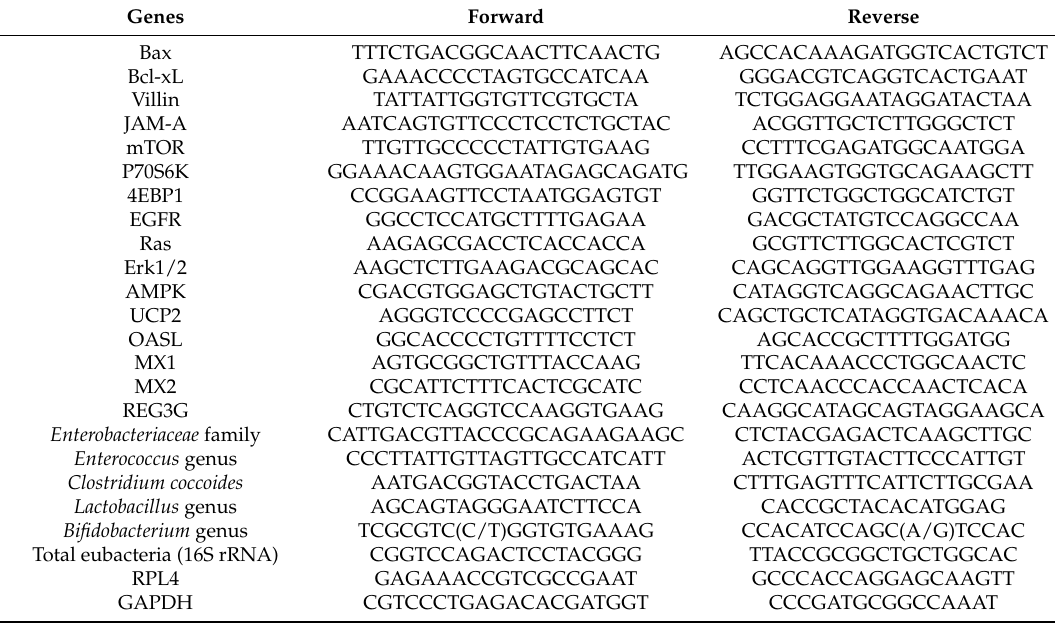
Table 5. Sequences of the primers used for quantitative real-time PCR